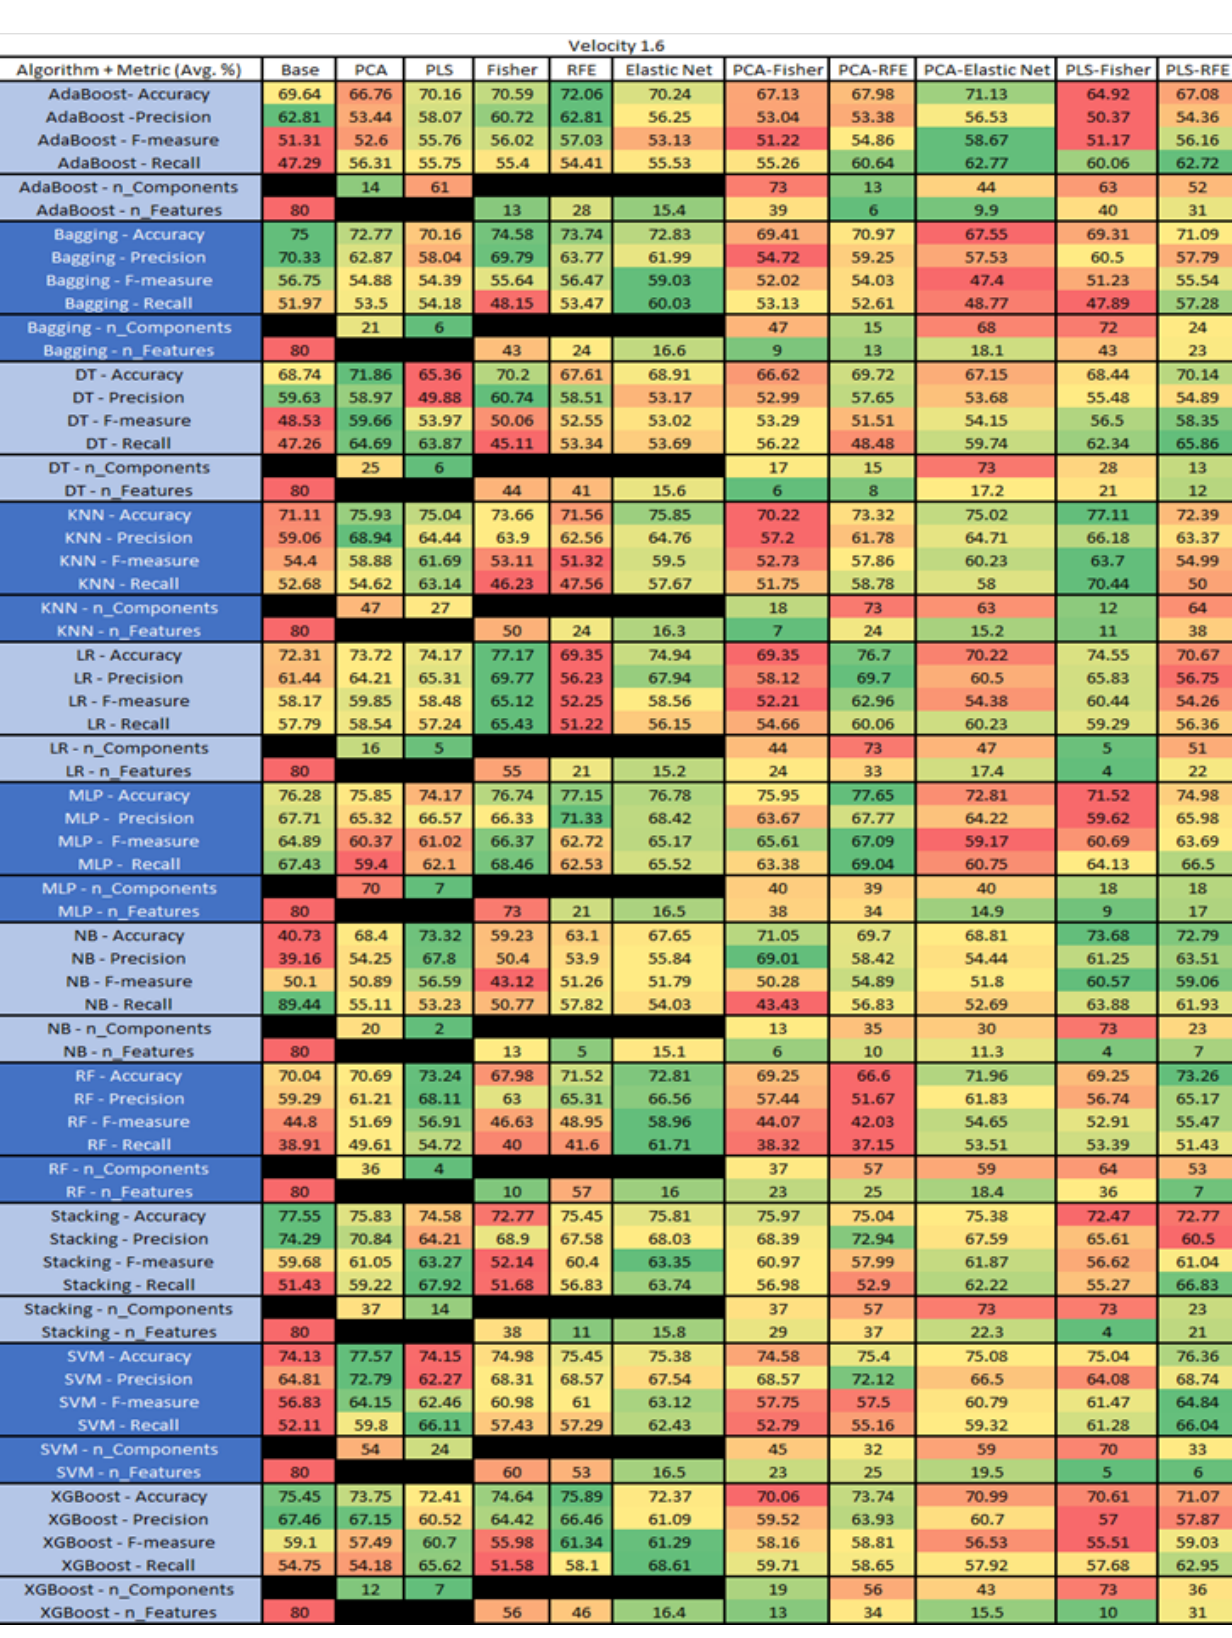
Figure 54. Velocity 1.6 PROMISE Results Data